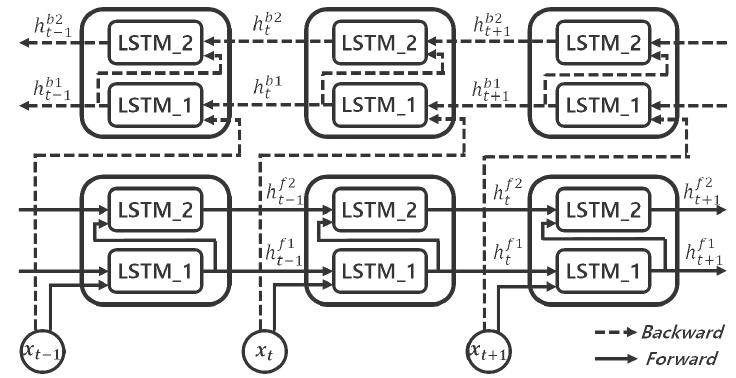
Figure 5. Operation of two-stacked bidirectional LSTM RNN model.